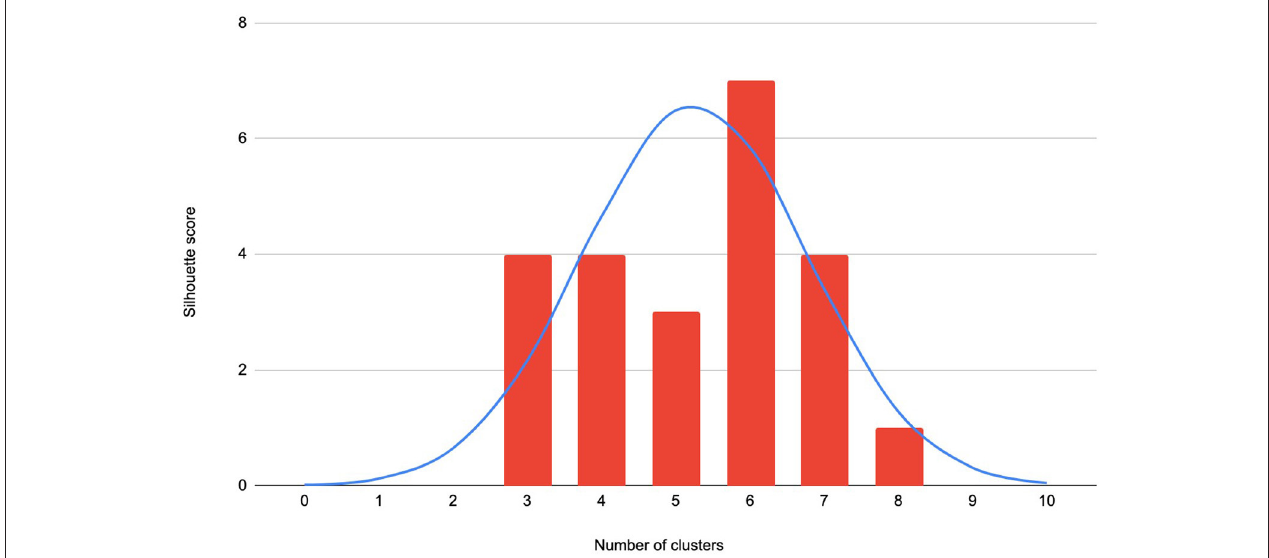
FIGURE 3 | The distribution of the Silhouette scores of optimal k-values for analyzed accounts (A high Silhouette score for a number k in the x axis, means that the data can be coherently partitioned into k groups).